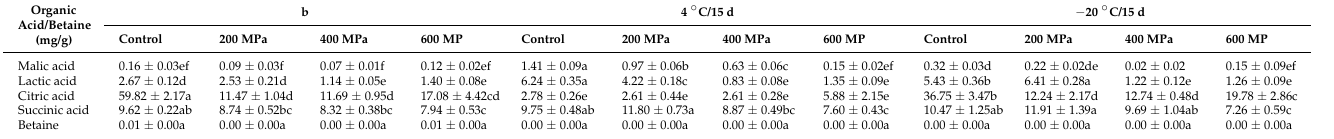
Table 4. The concentrations of organic acids and betaine in red claw crayfish with different